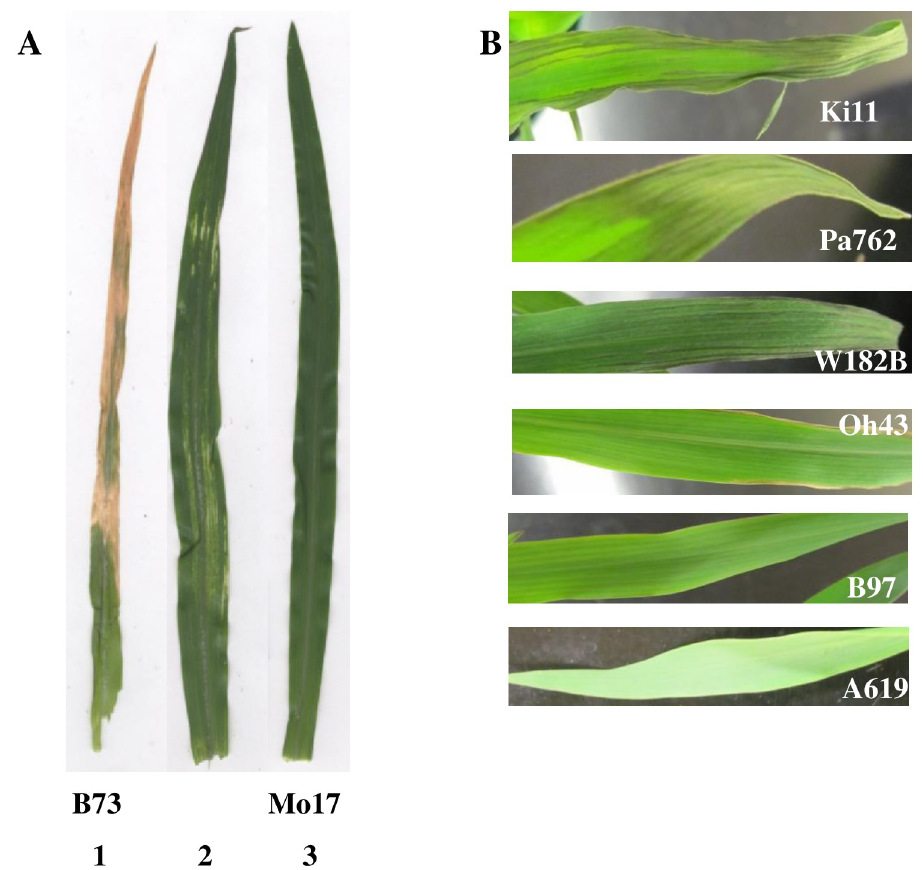
Fig 1. Effect of low temperature exposure of maize seedlings on leaf phenotype. A. The scale for visual scoring of tolerance to low temperature exposure was as follows: 1 –severe leaf damage, large proportion of dry / dead tissue, severe wilting; 2 –intermediate level of leaf damage, some discolored / dry tissue, primarily on the edges and tips of the leaf; 3 –minimal / no leaf damage, no discoloration, minimal wilting. B. Diverse maize lines vary in their response to low temperature